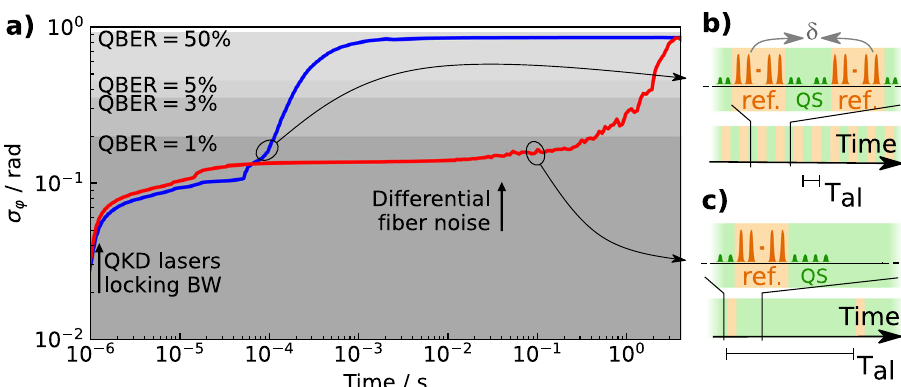
Fig. 4 Phase fl uctuations over time. a The deviation of the phase σ φ between the two QKD lasers interfering in Charlie at different timescales, in an unstabilized (blue) and stabilized (red) condition. For this calculation, we acquired the interference pattern over 4 s and subdivided it into shorter time frames, calculating σ φ for each frame. The shadowed areas indicate upper thresholds for relevant values of the QBER. The phase and corresponding QBER were retrieved from the interference pattern according to the procedures described in the “ Methods ” . The arrows indicate timescales where the QKD lasers noise and the uncompensated fi ber noise (differential fl uctuations at the two wavelengths) become relevant. For a given TF-QKD implementation, the quantum states transmission (QS) must be interleaved with realignment frames encoding a reference phase (ref.) after a time T al . This allows detection and stabilization of the interferometer noise δ , and ensures that a speci fi ed QBER is not exceeded: in our case, to preserve a QBER < 1%, T al amounts to 100 μ s and 0.1 s using an unstabilised or stabilized interferometer respectively. While in the former case realignment frames are absolutely required ( b ), in the latter case it becomes possible to exploit variations in the QBER itself to derive information about the interferometer phase noise and stabilise it. Even in the worst case scenario in which this is not possible because of a too high fi ber loss, realignment frames need to be applied at a much slower rate ( c ), effectively enabling duty cycles higher than 90% (see Supplementary